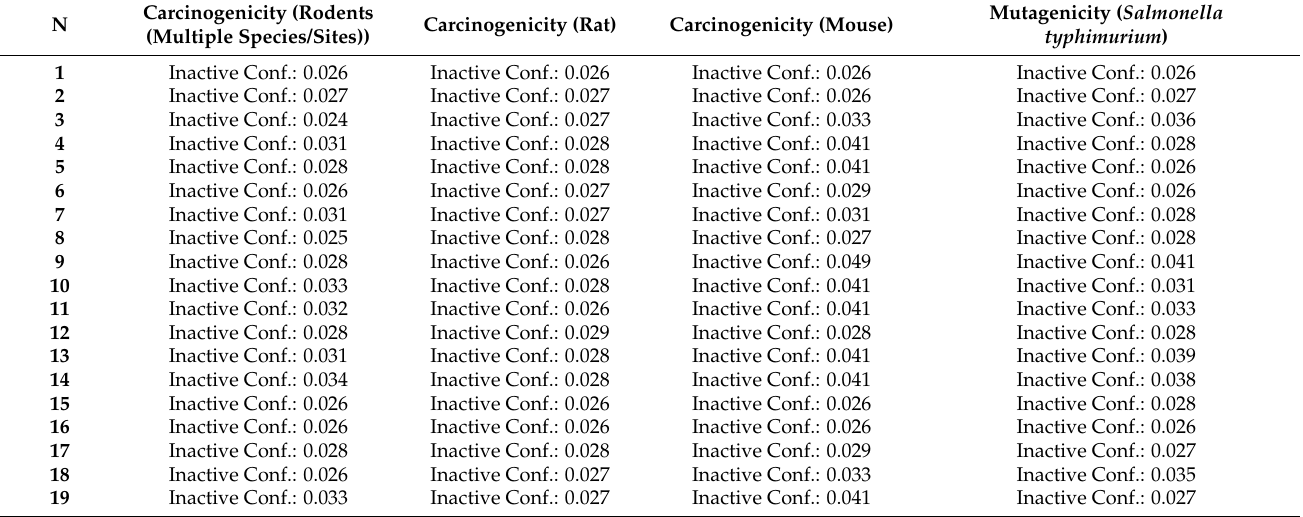
Table 2. Prediction of carcinogenicity and mutagenesis of compounds by ToxPredict